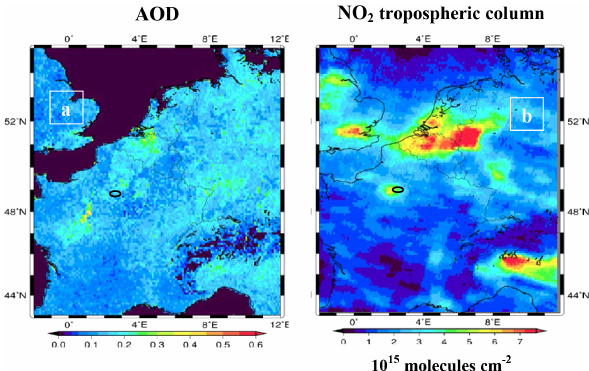
Figure 4. AOD (aerosol optical depth) from the AATSR (Ad- vanced Along Track Scanning Radiometer instrument) (a) , tropo- spheric NO 2 columns from SCIAMACHY observations, both av- eraged over the period March–October 2009 (b) . The black ovals marks the Paris agglomeration. AOD values are only given over land areas (black over sea).